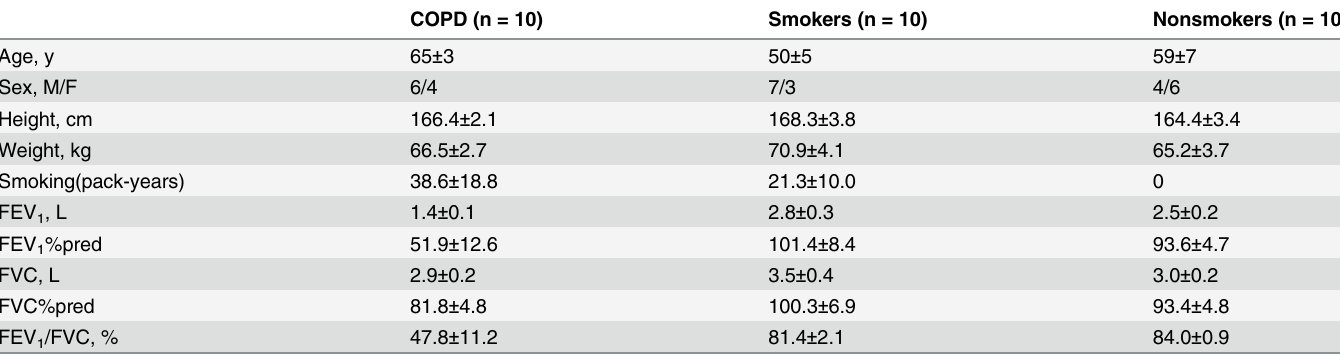
Table 1. Baseline characteristics of the study subjects. *